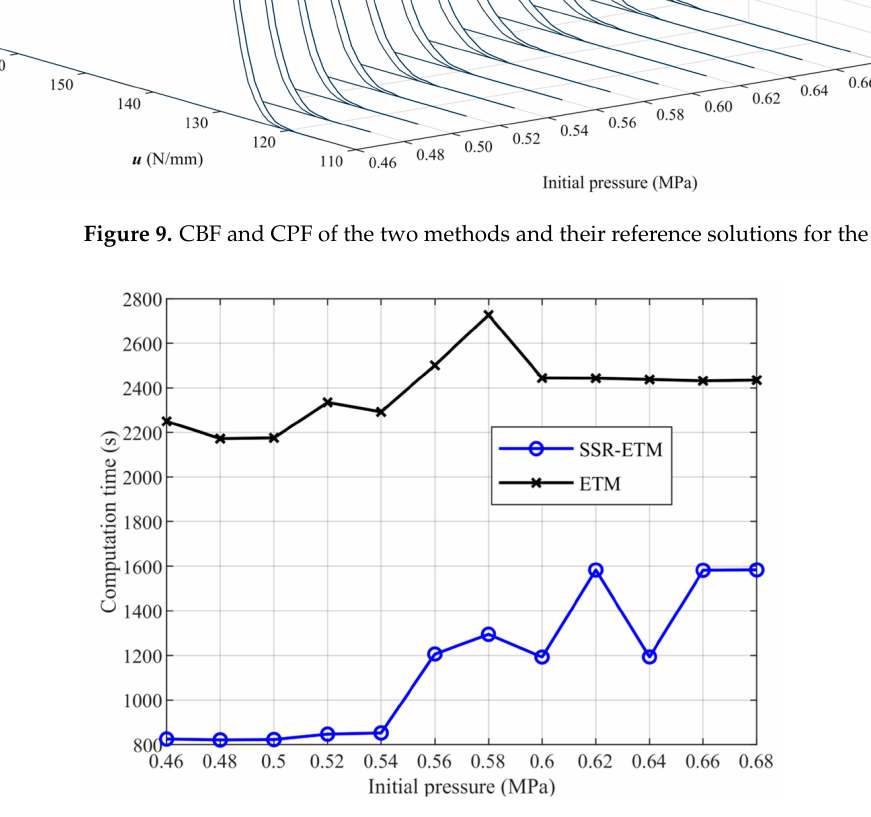
Figure 10. Computation time of the two methods at different initial